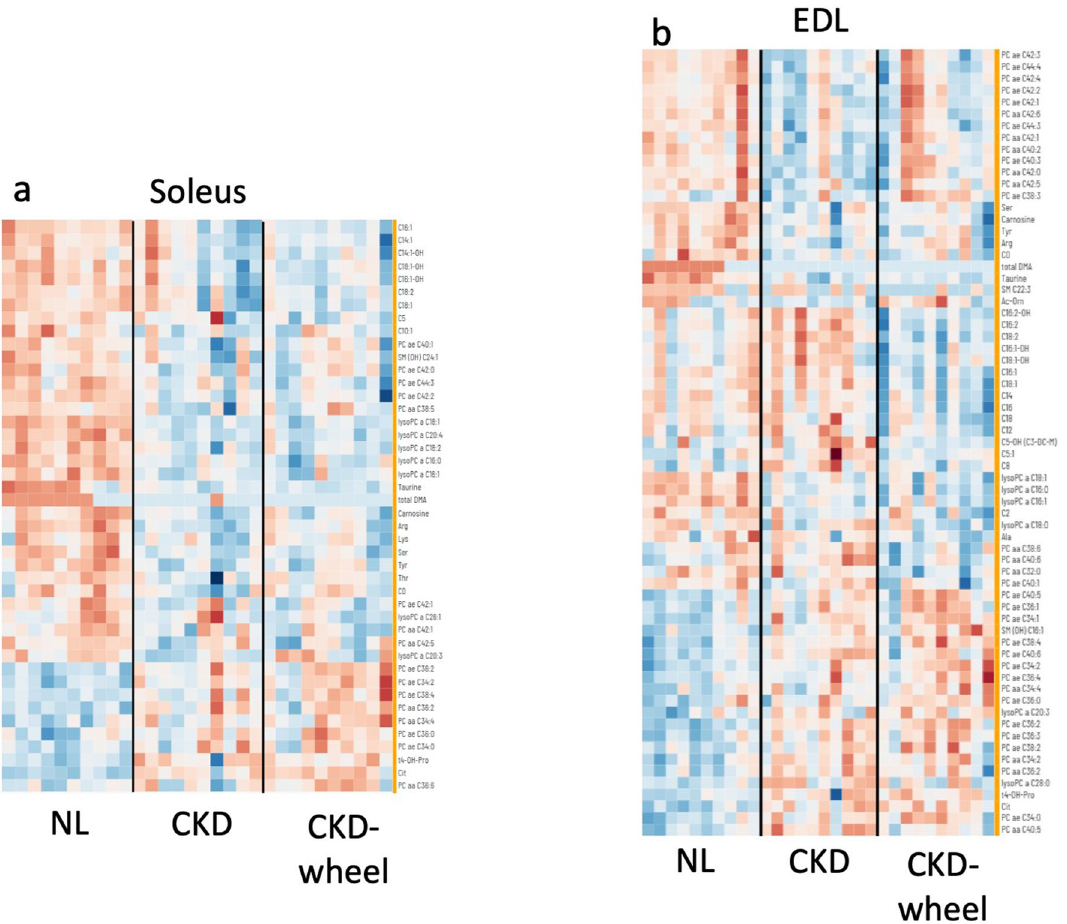
Figure 1. Heatmaps of metabolomics data from the soleus and EDL. The heatmaps include the significantly altered metabolites in each tissue presented as z-scores for ( a ) soleus and ( b ) EDL. The metabolites are ordered with K-nearest neighbors hierarchical